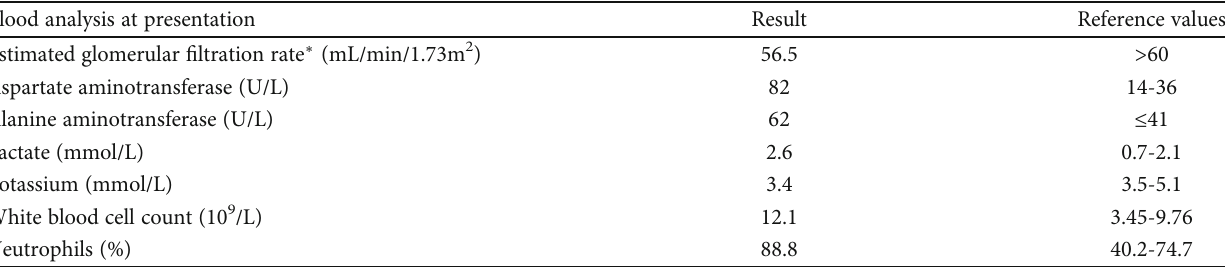
Table 1: Blood analysis at presentation in the ED.